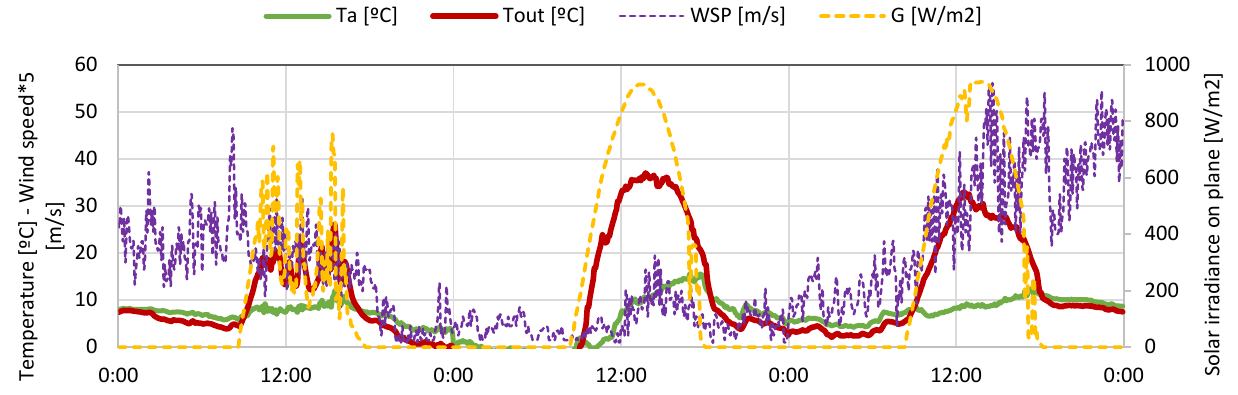
Figure 8. Detail of three days in winter: inlet/outlet temperatures, wind speed and solar irradiance.